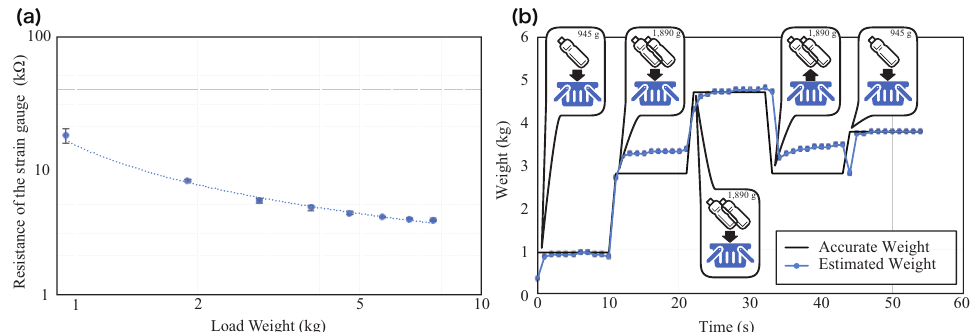
Figure 11. ( a ) Behavior of the strain gauge resistance to loading weight. ( b ) Behavior of estimated weight with changes of the load